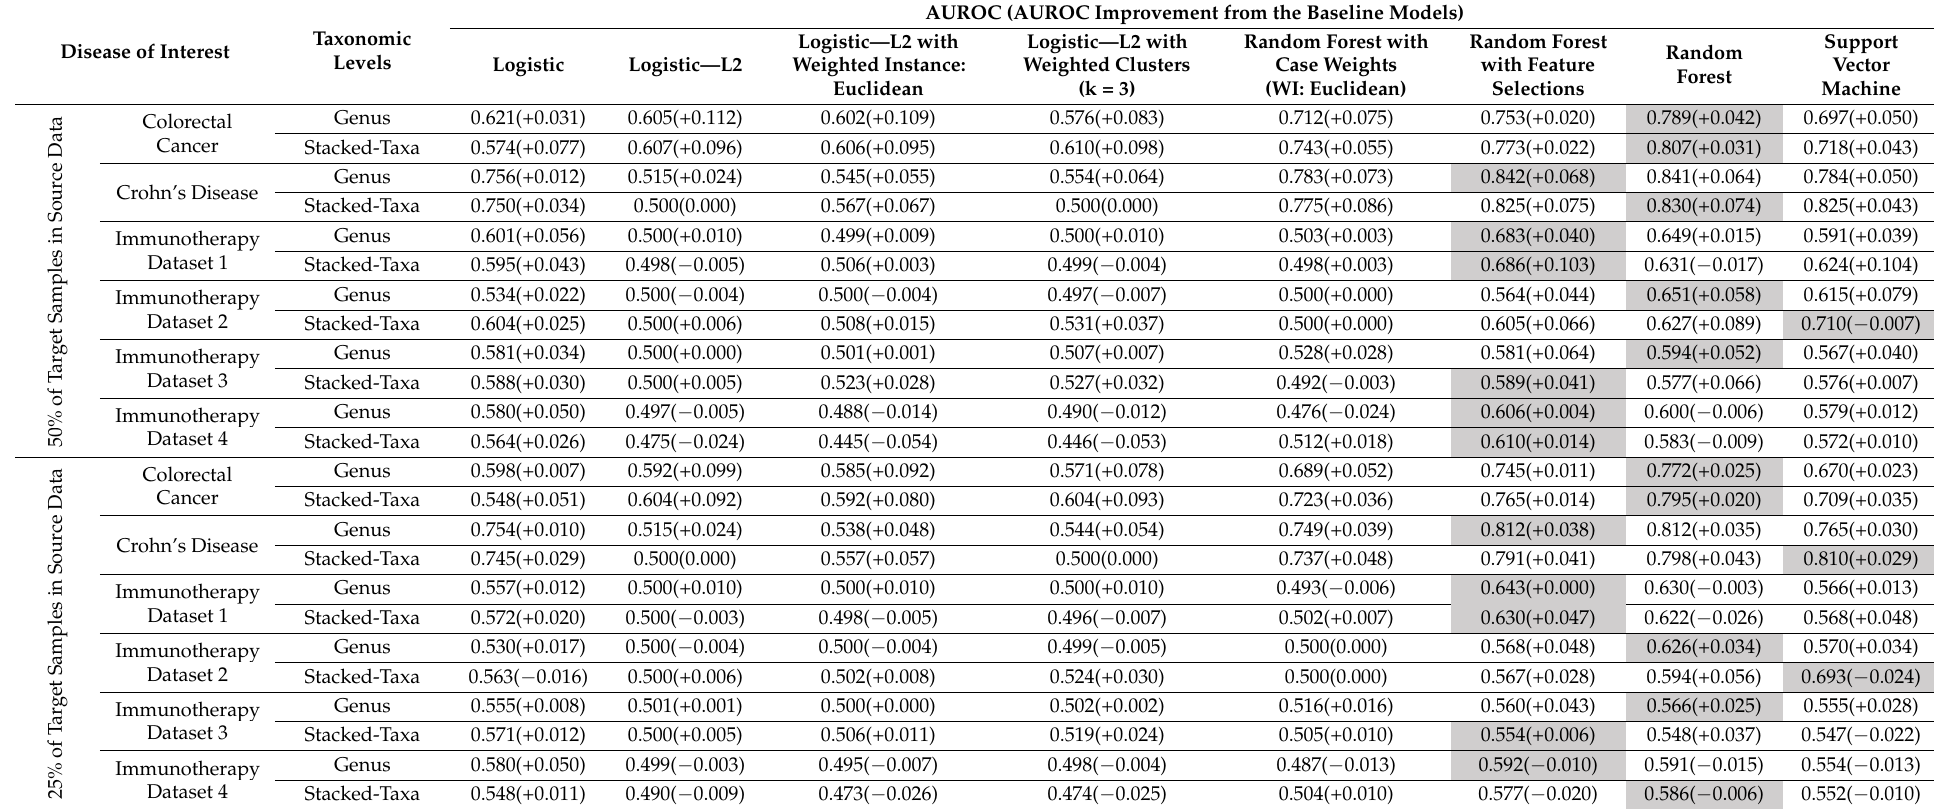
Table 2. Machine learning area under the curve (AUROC) for 25% and 50% target samples in source data. Gray-lighted cell contains the highest machine learning average AUROC for the taxonomic level and disease of interesting comparison